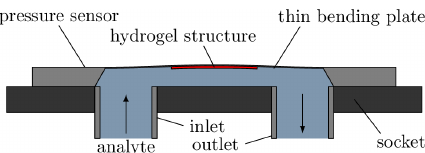
Figure 1. Cross-section of the sensor used. The cavity between the socket and the sensor chip forms a fluid chamber. Swelling of the hydrogel on the inside of the bending plate results in deflection due to the bimorph effect and thus a sensor signal dependent on the degree of swelling.